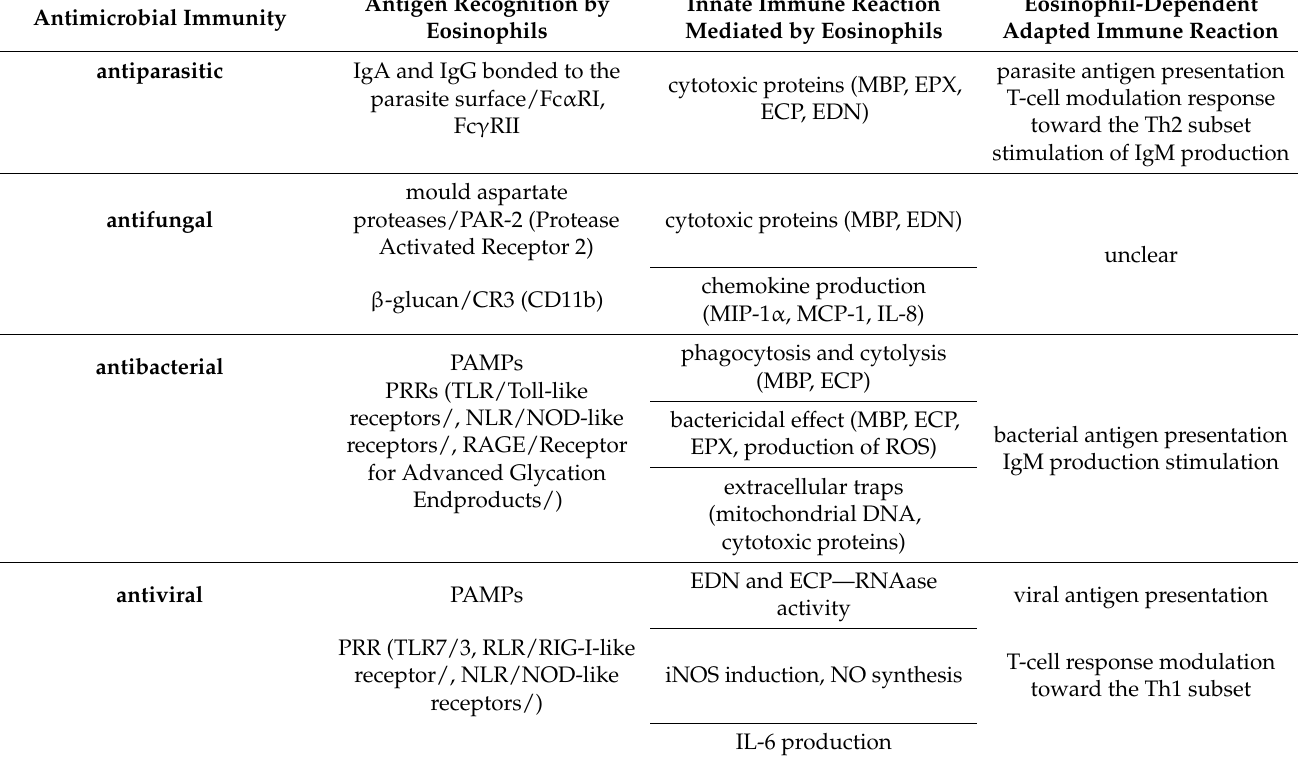
Table 3. Antimicrobial roles of